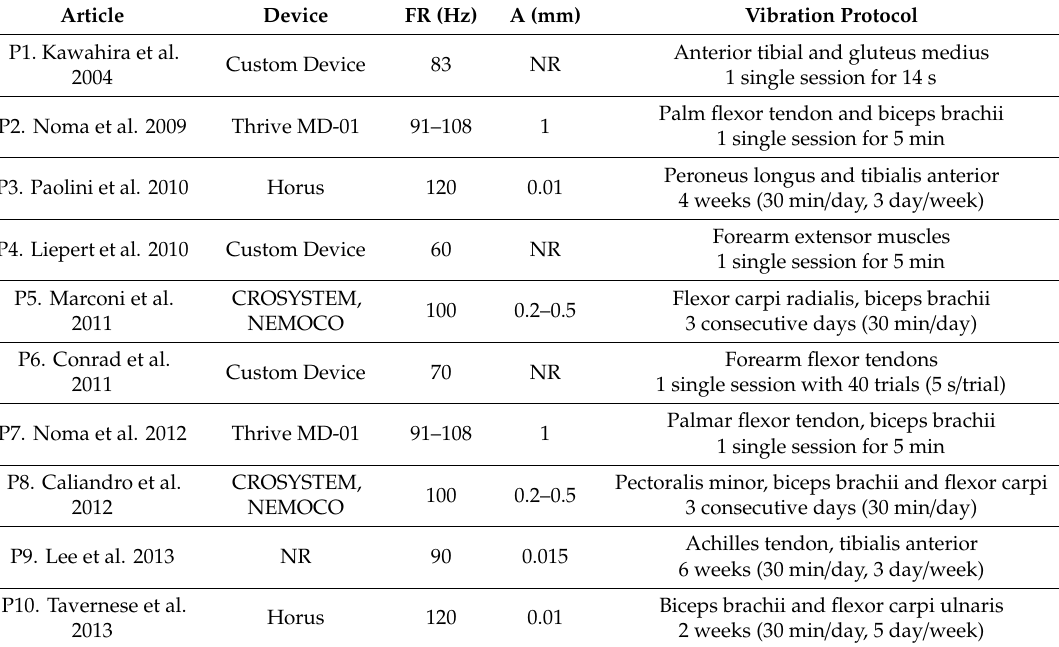
Table 2. Vibration devices, parameters, and protocols used in the included